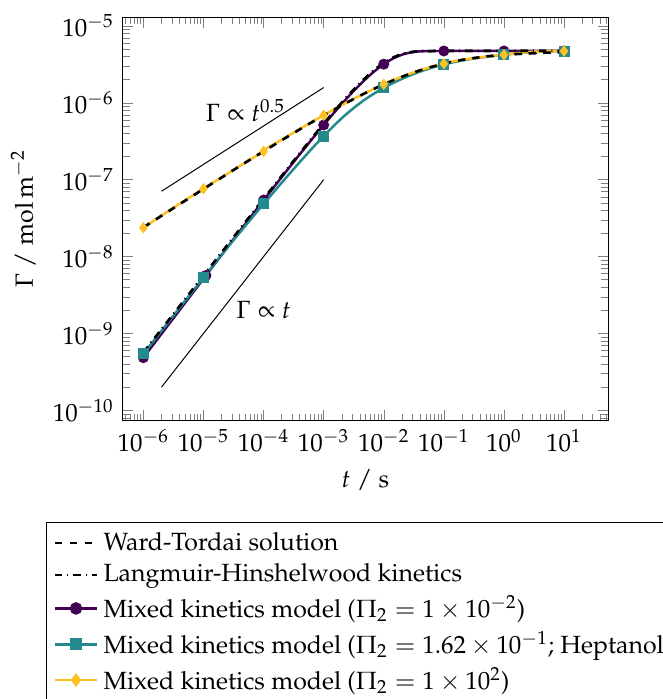
Figure 3. Verification of the mixed kinetics model with numerical and analytical reference solutions.